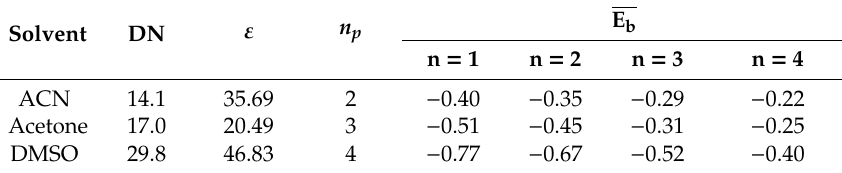
Table 3. The predicted coordination number ( n p ) as well as the average binding energies (E b ) with di ff erent number of binding solvent molecules (n) on Li + cation. The donor number (DN) and the dielectric constants ( ε ) of di ff erent solvents are also